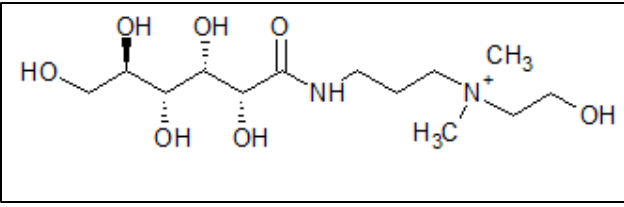
Figure 1. Quaternium-22 molecular